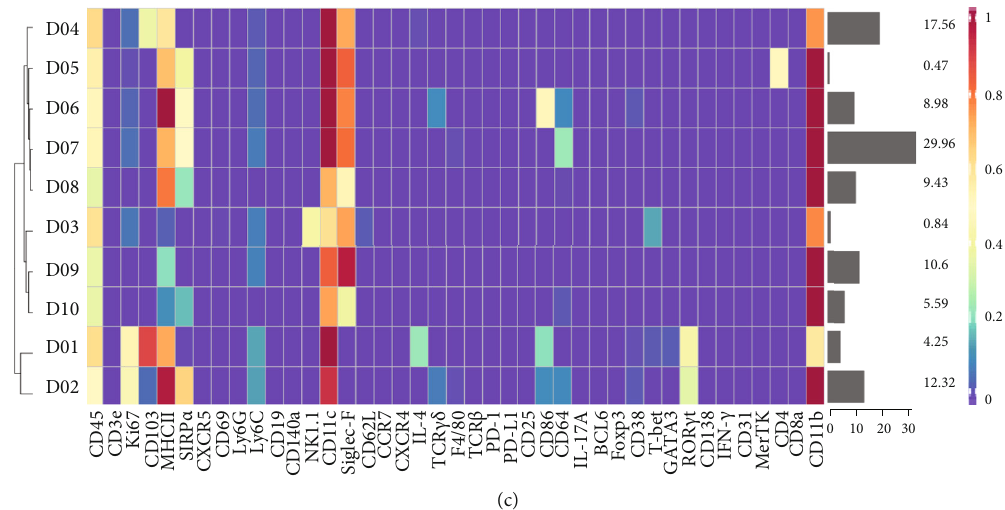
Figure 2: Identi fi cation of the dominant immune components in nephrolithiasis models. (a) Heatmap showing normalized expression of the 42-antibody panel markers for the 20 T cell clusters identi fi ed with PhenoGraph. (b) Heatmap showing normalized expression of the 42-antibody panel markers for the 20 macrophage clusters identi fi ed with PhenoGraph. (c) Heatmap showing normalized expression of the 42-antibody panel markers for the 10 DC clusters identi fi ed with PhenoGraph. Clusters are grouped by expression pro fi le with the relative frequencies that are displayed as a bar graph on the